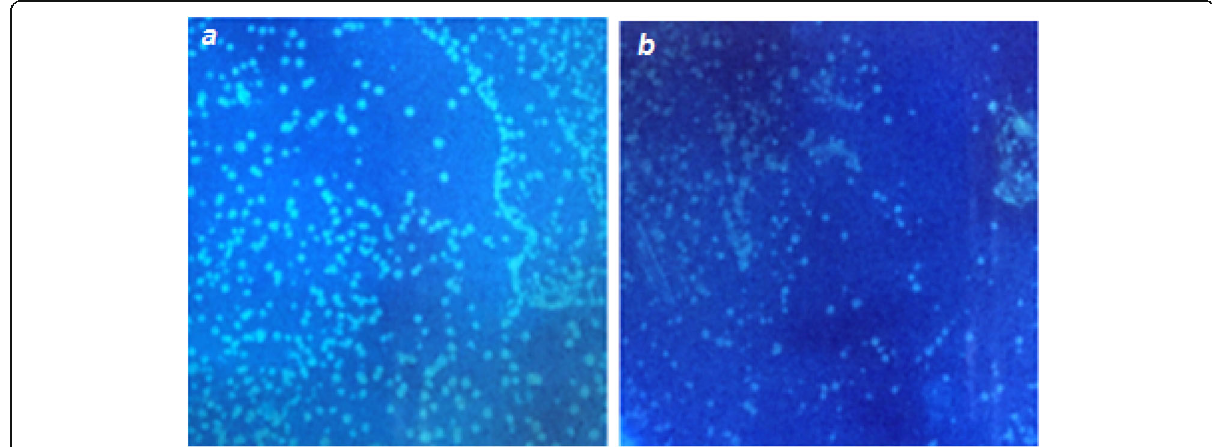
Fig. 5 Detection of fluorescence in bacterial colonies on MRSA plates under UV light. a P. acidilactici MTCC 5101. b L. brevis MTCC 1750